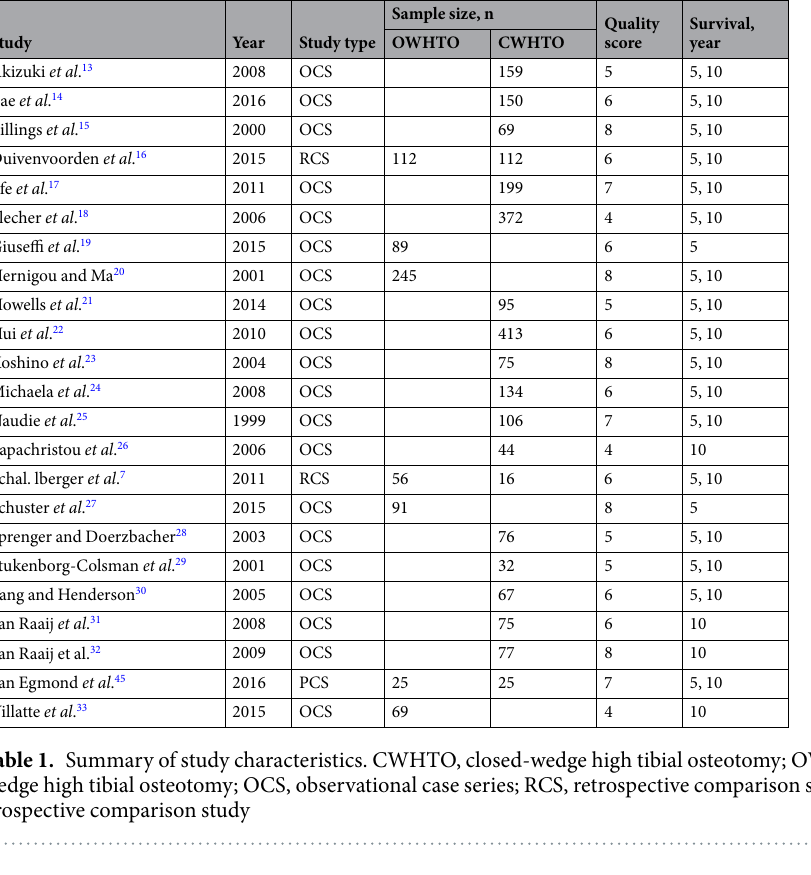
3 SCientifiC RepORTS | 7: 7296 | DOI:10.1038/s41598-017-07856-8